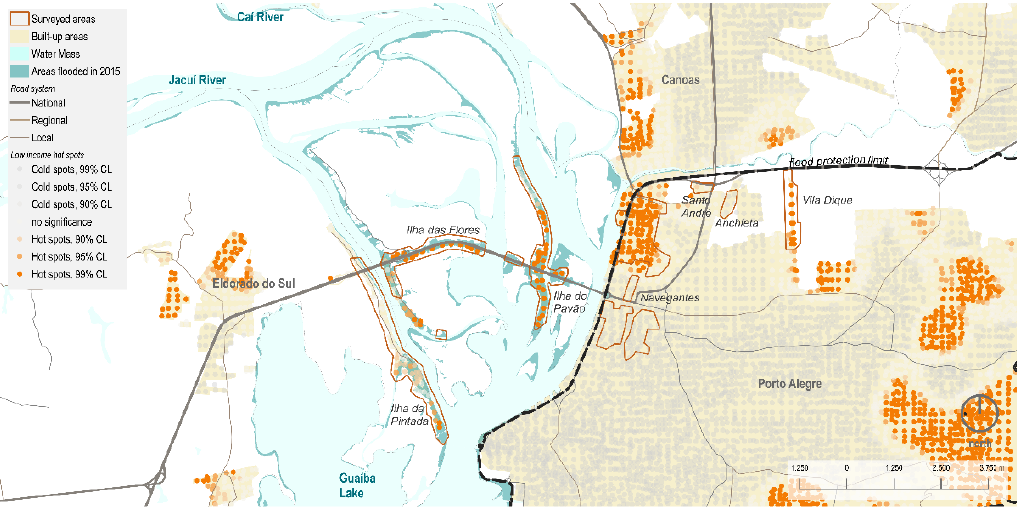
Figure 3. Location of surveyed areas, protection status, hot spots of low-income households, and areas affected by the October 2015 flood.